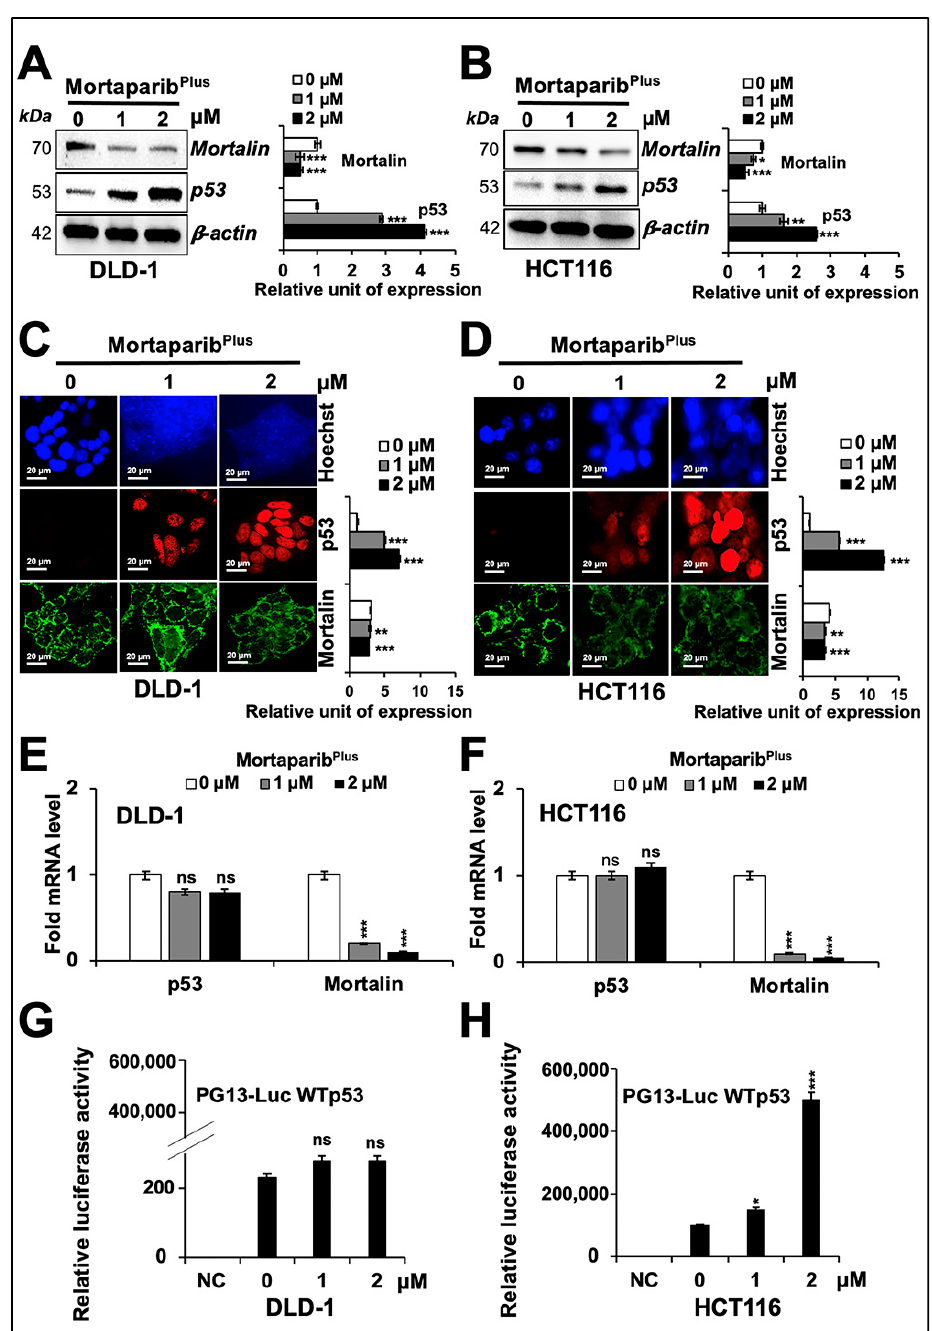
Figure 3. Mortaparib Plus down-regulated mortalin levels in colorectal cancer cells. Cells treated with Mortaprib Plus for 24 h were analysed for the expression levels of mortalin and p53 with respect to the untreated control cells by Western blotting ( A , B ), immunocytochemistry ( C , D ), and real-time quantitative polymerase chain reaction (RT-qPCR) ( E , F ). A decrease in mortalin and increase in p53 levels were confirmed in all the methods adopted. Wild-type p53-specific luciferase reporter assays (PG13-luc) did not show any significant increase in p53-driven luciferase activity in Mortaparib Plus -treated DLD1 (p53 S241F ) cells ( G ). HCT116 (p53 WT ) cells 24 h-treated with Mortaparib Plus showed a dramatic increase in luciferase activity using the same reporter assay systems ( H ). The quantified data represents mean ± SD obtained from three independent biological replicates; p -values were calculated using unpaired Student’s t -test. * < 0.05, ** < 0.01, and *** < 0.001 represent significant, very significant and very very significant, respectively. Scale bar in C and D equals 20 µ